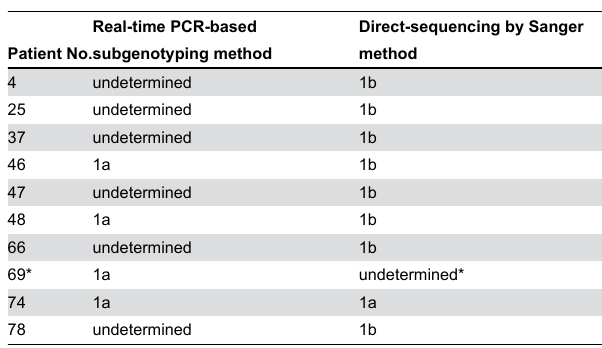
Table 2. Results of HCV subgenotype determining by real- time PCR-based method and direct-sequencing by Sanger